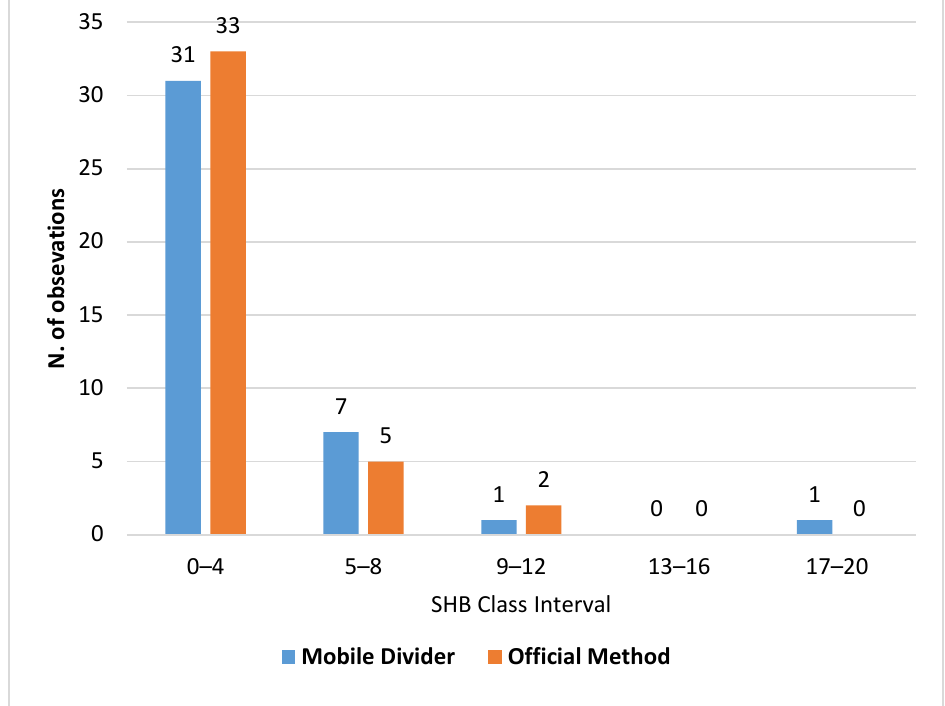
Figure 2. Number of observations per class intervals for each method. Table 5. Summary results of the number of A. tumida detected and inspection time required. N. of SHB